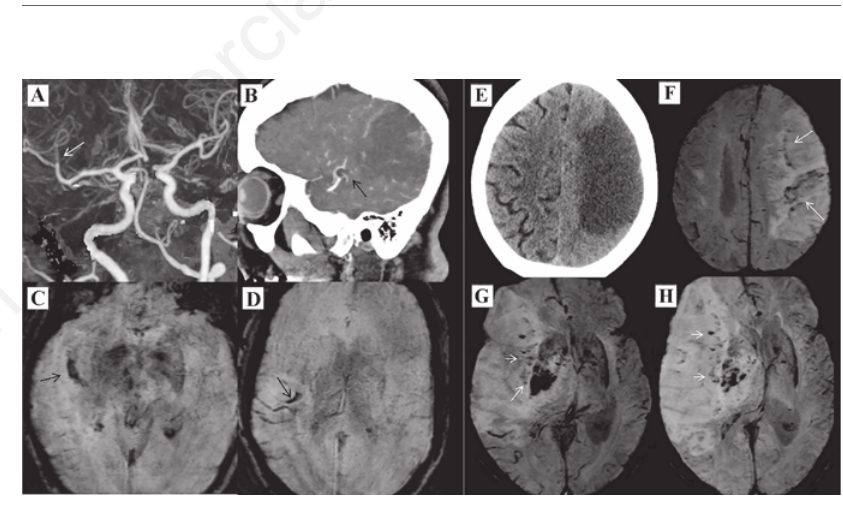
Figure 2. A-D) A 63-year-old female presenting with acute left-sided weakness. A) CT angiogram (MIP image) shows abrupt complete occlusion (white arrow) of posterior M2 branch of the right MCA, with poor visualization of distal branches. B) Sagittal CTA images, shows the location of vascular occlusion (black arrow), however presence of any distal clot/branch occlusion cannot be ascertained. C) SW-mIP axial images show the main intra-arterial clot in the posterior M2 branch of MCA(black arrow), corresponding to the CTA findings. D) A second distal clot is noted in the M4 cortical branch on the same side (black arrow).This was not seen on CTA even after retrospective evaluation.